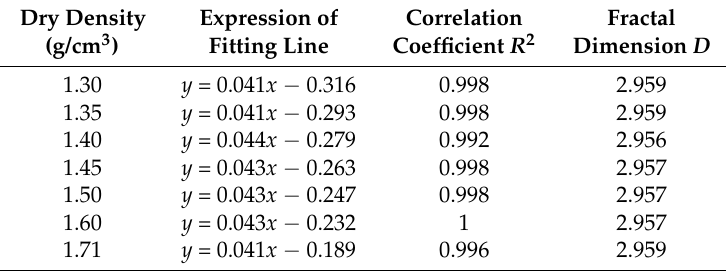
Table 2. Fitting results of fractal dimension corresponding to Figure 6b.